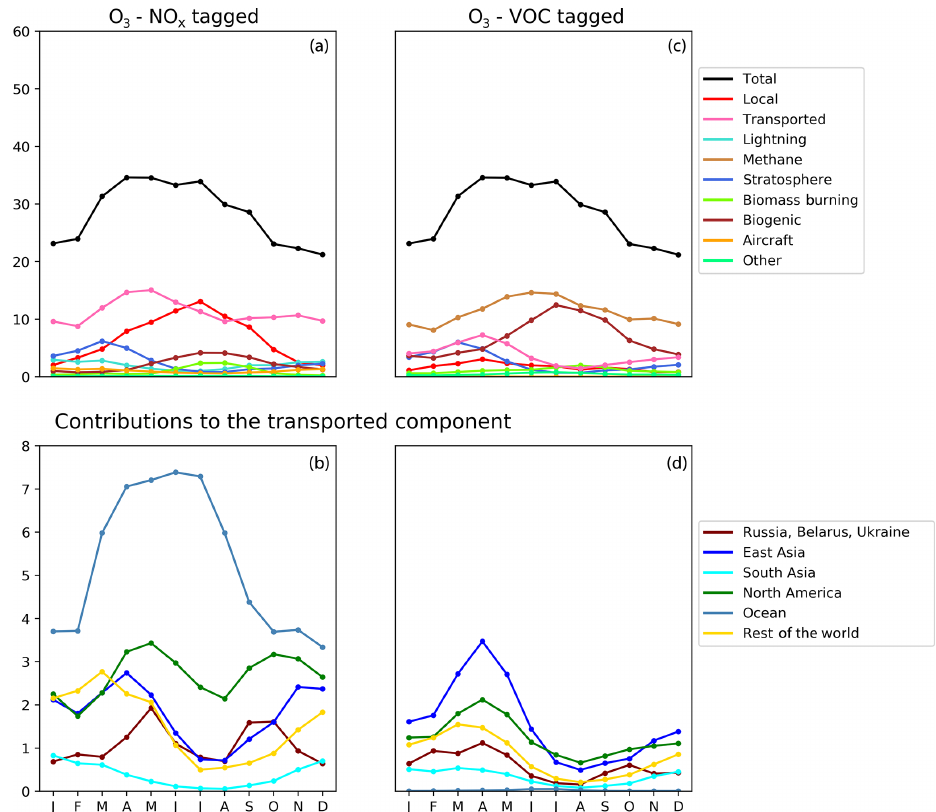
Figure 5. Seasonal cycle of surface ozone (ppb) in the HTAP Tier 2 receptor region “North West Europe”. NO x tagging is shown in panels (a) and (b) , and reactive carbon tagging is shown in panels (c) and (d) . Panels (a) and (c) show the total monthly mean ozone (black line) as well as the local anthropogenic component, the long-range transported anthropogenic component, and the natural components. Panels (b) and (d) show the individual Tier 1 source regions responsible for the long-range transported component of